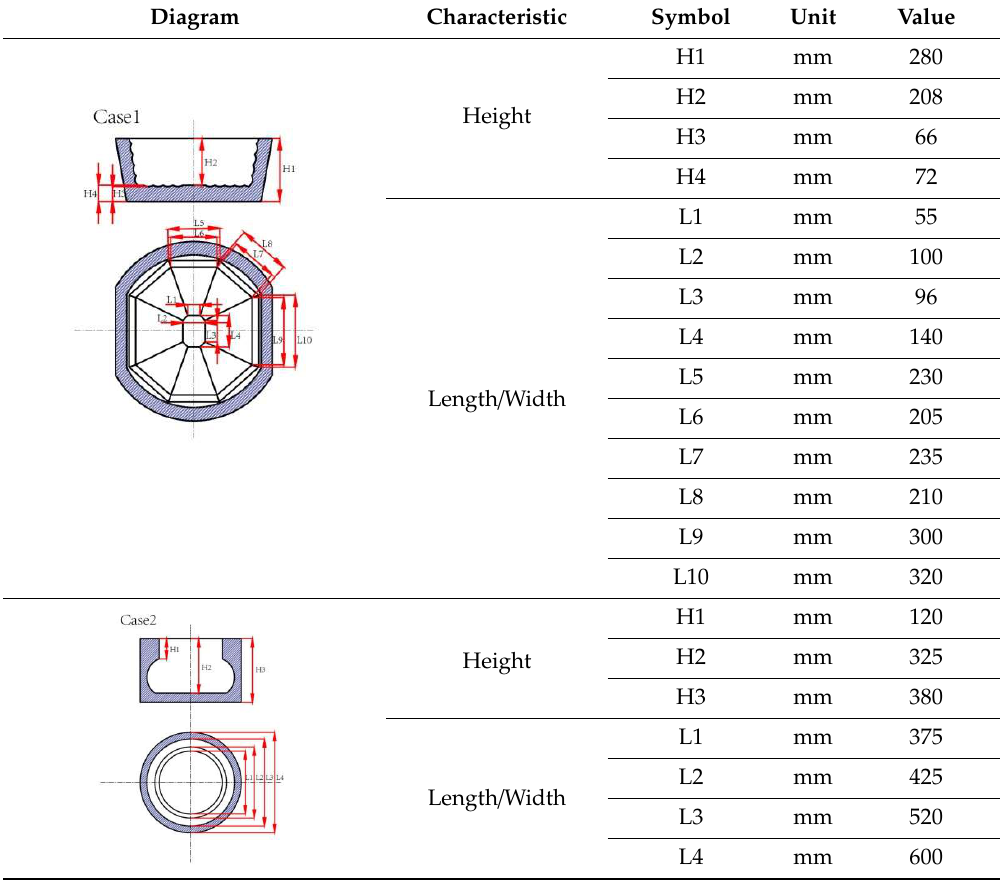
Table 2. The basic structure and parameters of different turbulence